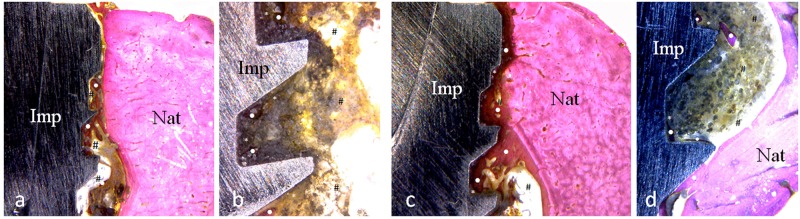
Representative images of the CON group.(a) cortical portion with 3-weeks, (b) medullar portion with 3-weeks, (c) cortical portion with 4-weeks, (d) medullar portion with 4-weeks. Images obtained by light microscopy. New bone formed (●), osteoid matrix (*), medullary spaces (#), implant (Imp) and native bone (Nat).